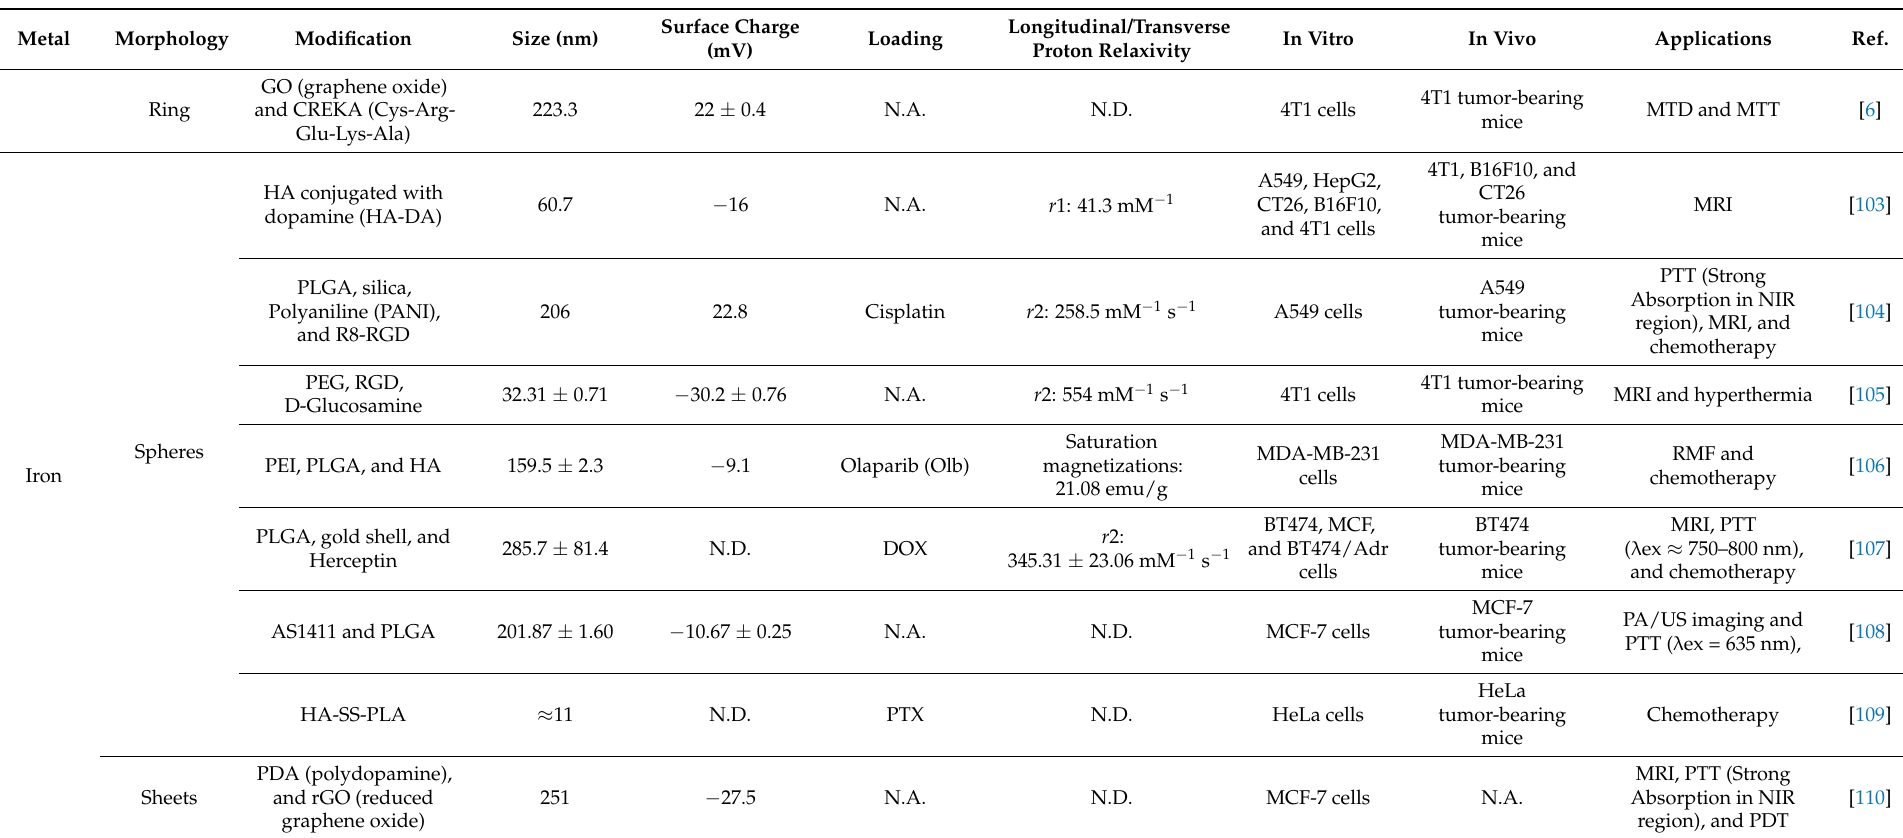
Table 2. Iron-based metallic-polymer nanoconjugates/nanohybrids, their physicochemical properties, and therapeutic applications (N.D.—non disclosed, N.A.—not